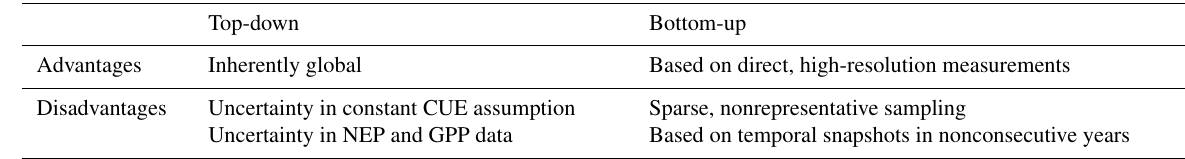
Table 1. Advantages and disadvantages of top-down vs. bottom-up estimation methods. Top-down Bottom-up Advantages Inherently global Based on direct, high-resolution measurements Disadvantages Uncertainty in constant CUE assumption Sparse, nonrepresentative sampling Uncertainty in NEP and GPP data Based on temporal snapshots in nonconsecutive